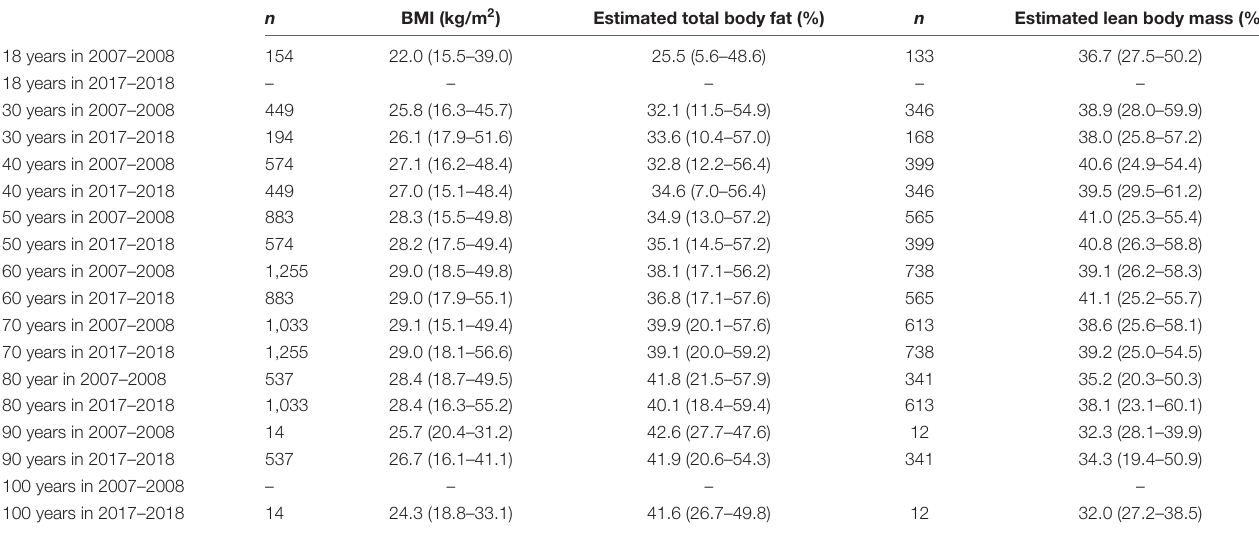
TABLE 2 | Evolution of mean body mass index and estimated total body fat and lean body mass by intervals of 10 years from 18 to 100 years in both periods of time (2007–2008 and 2017–2018).